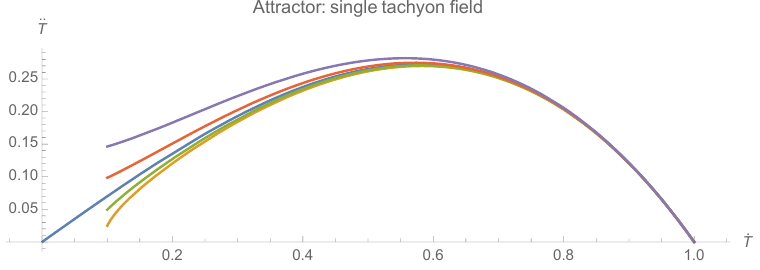
Figure 1 . The parametric plot of ˙ T and ¨ T illustrates that ( ˙ T , ¨ T ) = (1 , 0) is a dynamic attractor for the single tachyon field model. The longest curve is plotted by solving eq. (2.2) numerically with initial condition ( T (0) , ˙ T (0)) = (0 . 001 , 0 . 001) while other curves are plotted with (0 . 05 , 0 . 1) , (0 . 1 , 0 . 1) , (0 . 2 , 0 . 1) , and (0 . 3 , 0 . 1) respectively. All curves converge into the fixed point ( ˙ T , ¨ T )